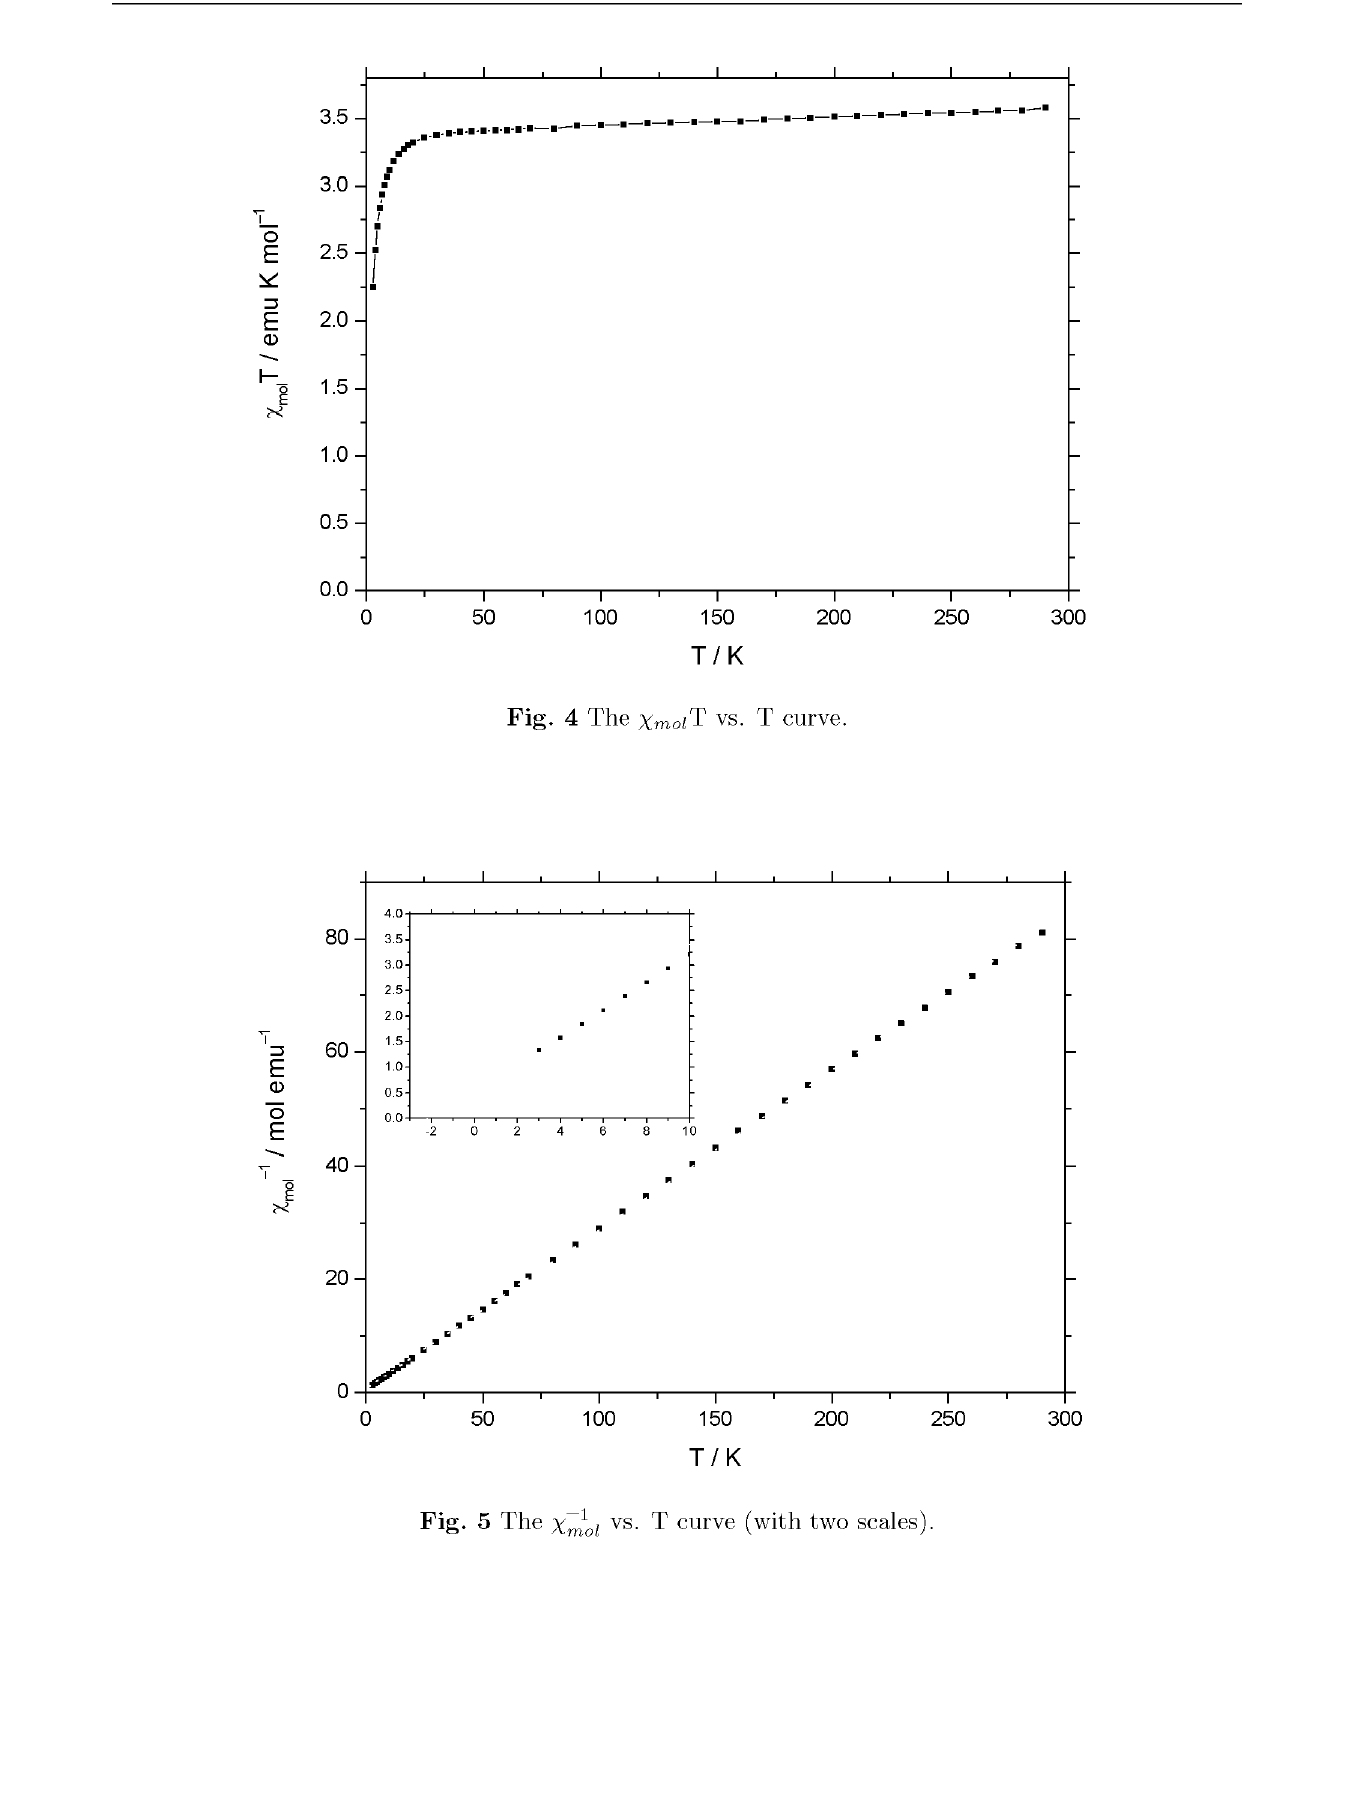
Fig. 5 The X~lol vs. T curve (with two